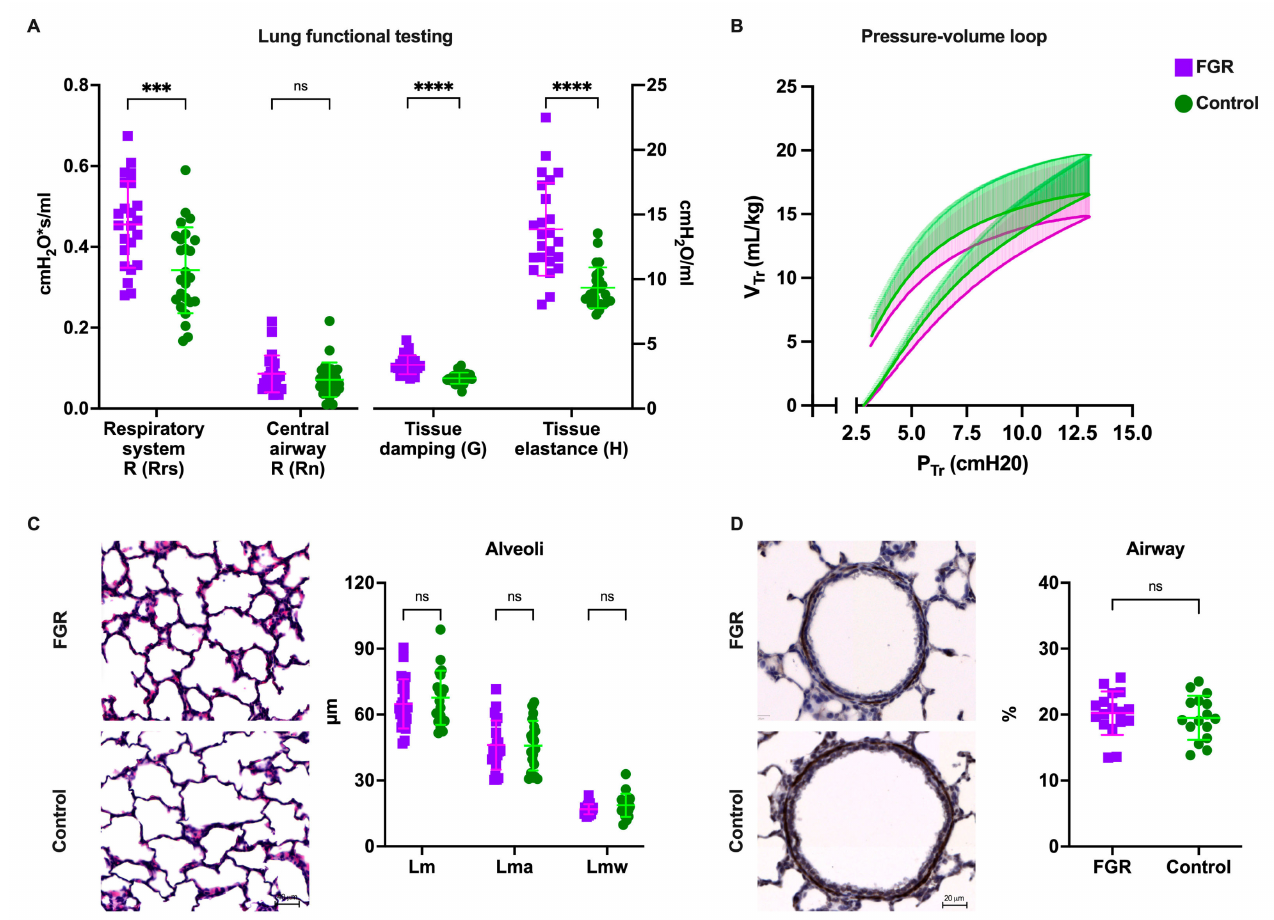
Figure 2. Pulmonary assessment tests at postnatal day 1: ( A ) biomechanical properties of parenchy- mal tissue and central airway; ( B ) pressure–volume curve, corrected by body weight; ( C ) alveolar morphometry in H&E slides; ( D ) airway smooth muscle content in α -SMA slides. Data were analyzed using a linear mixed-effects model and displayed as mean ± SD ( A , C ) or median and IQR ( D ), with significance as ns p >0.05; *** 0.001 > p > 0.0001; **** p < 0.0001. FGR: fetal growth restriction; Lm: mean linear intercept; Lma: alveolar air space; Lmw: interalveolar septal thickness; R: